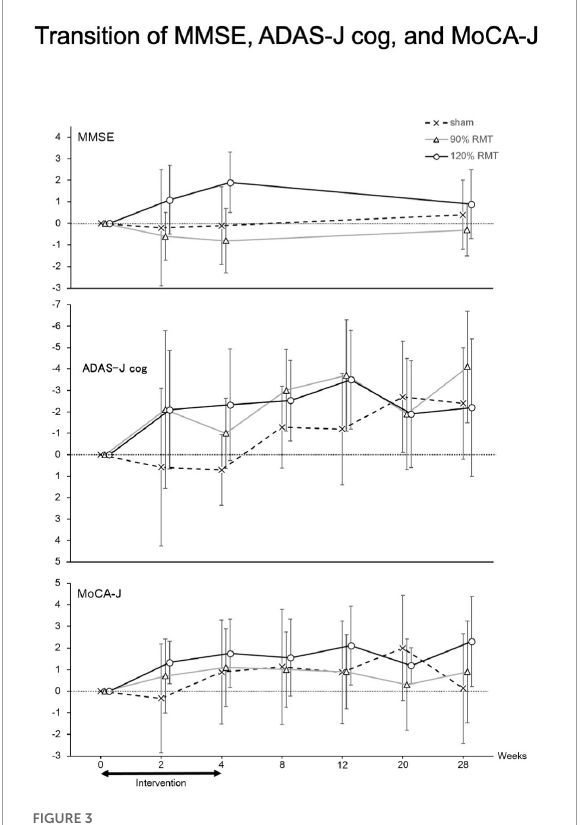
FIGURE3 Transition of MMSE, ADAS-J cog and MoCA-J. Thus, we only analyzed patients with MMSE scores > 15 and the resulting groupings were as follows: 120% RMT group, 12 patients; 90% RMT group, 10 patients; and Sham group, 9 patients. Among the patients, the 120% RMT and 90% RMT groups showed several improvements in the MMSE, ADAS- J cog and MoCA-J scores. Treatment efficacy appeared to disappear at 20 weeks. MMSE, Mini-Mental State Examination, ADAS- J cog, Alzheimer’s Disease Assessment Scale-Japanese Cognitive, MoCA-J, Montreal Cognitive Assessment, RMT, resting motor threshold, vertical axis: improved points from the